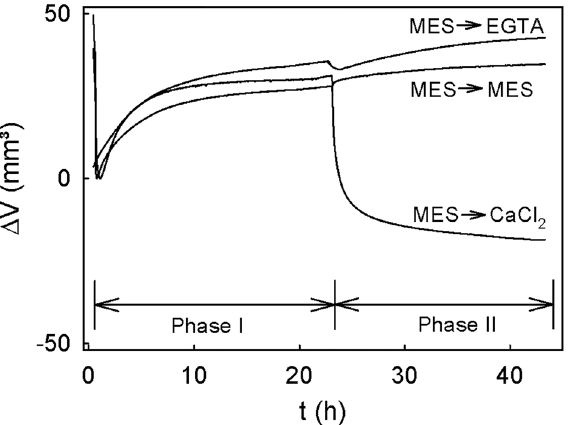
Figure 4. Time course of swelling of cell walls extracted from mature ‘Burlat’ sweet cherry. The experiment was conducted as a two-phase experiment by performing sequential treatments. During phase I, the cell walls were swelling in MES buffer. During the subsequent phase II, the buffer was replaced and swelling was monitored in buffered 10 mM CaCl 2 or buffered 5 mM EGTA (phase II) or MES buffer only (10 mM). The pH of all solutions was adjusted to pH of 5.8. Swelling was quantified as the change in volume (∆V) of the cell wall at a constant pressure of 3.9